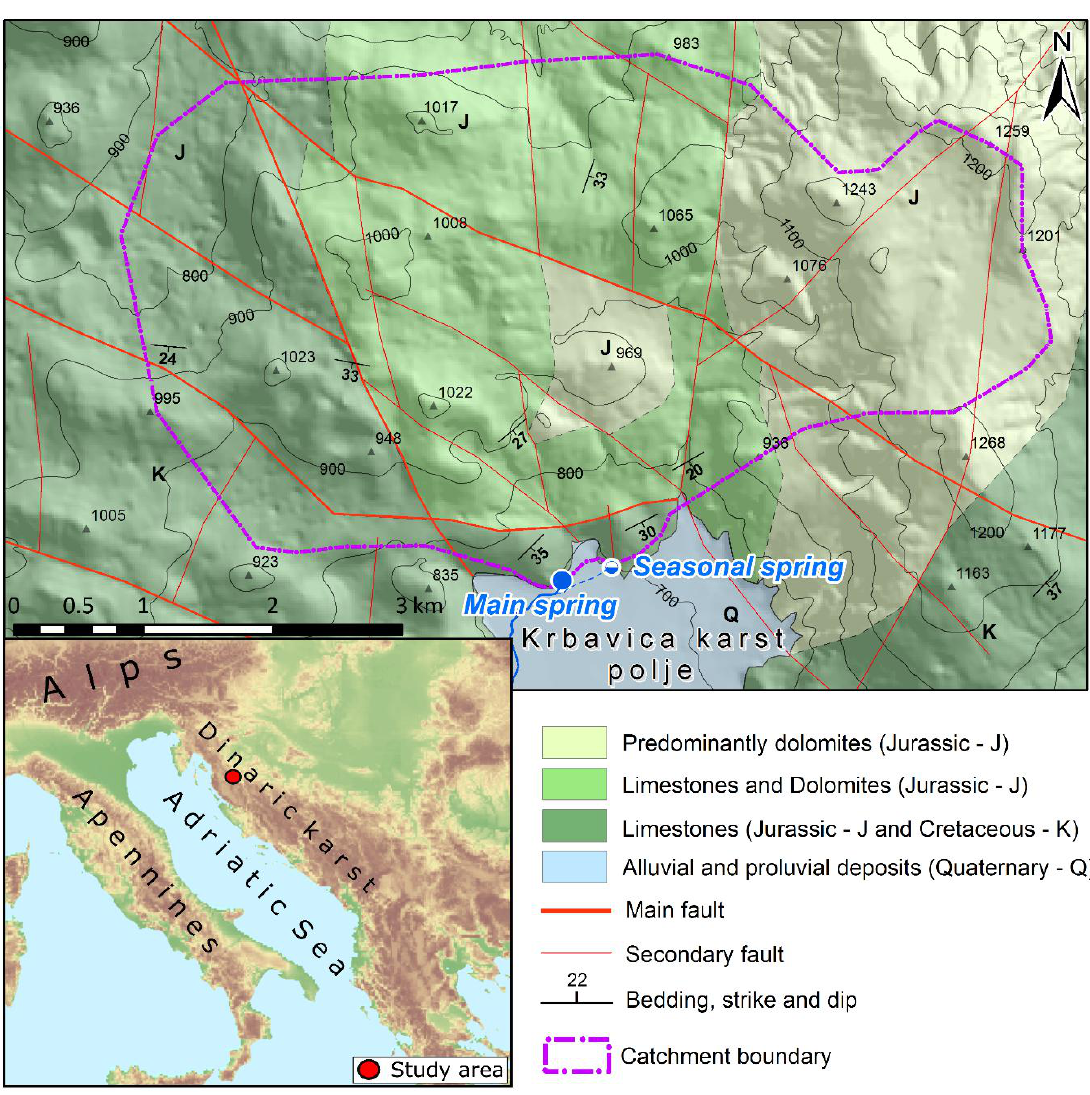
Figure 1. Position of the study area within the eastern Mediterranean region and hydrogeological map of the study area.